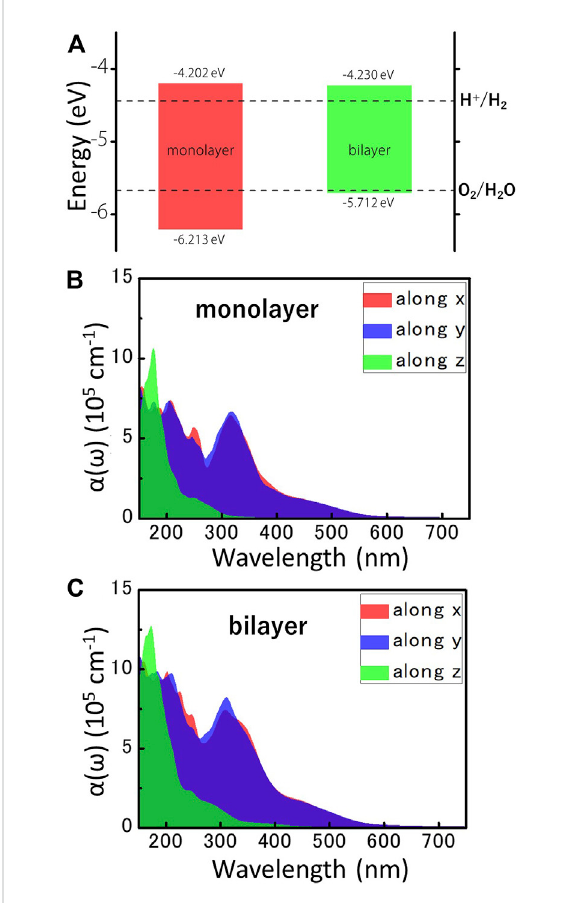
FIGURE 4 (A) The locations of VBM and CBM of MoWS 4 monolayer and bilayer, which are obtained by the HSE06 functional. The redox potentials of water splitting at pH = 0 are shown for comparison. All the energy levels are based on the vacuum level, and the vacuum level is set as 0 eV. The optical absorption coef fi cients for the different directions of (B) MoWS 4 monolayer and (C) MoWS 4